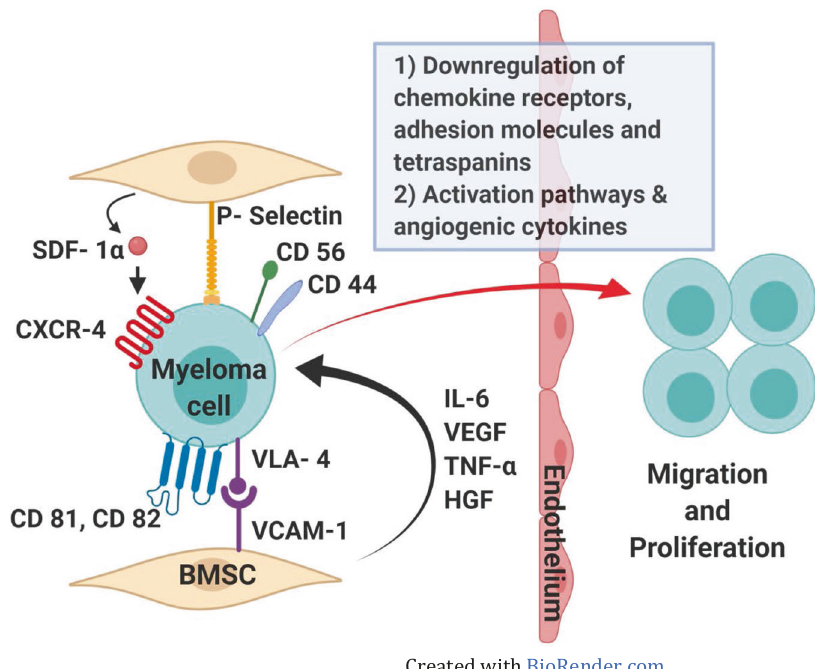
Created with BioRender.com